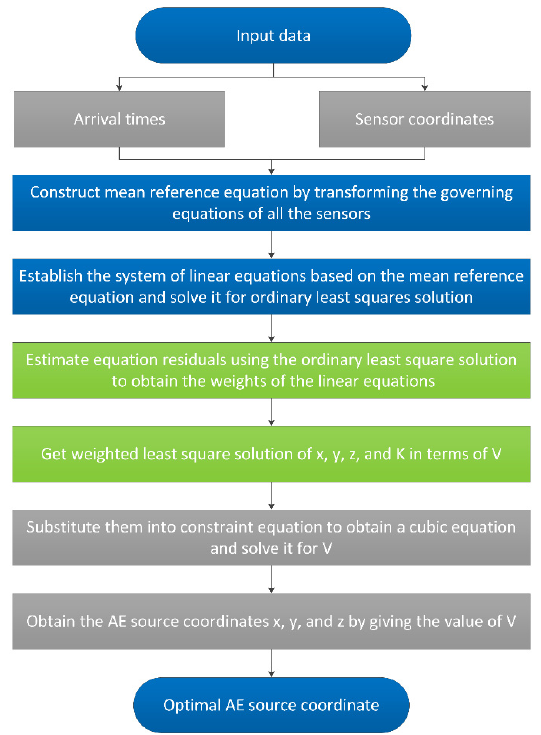
Figure 2. The whole location process of the proposed method.